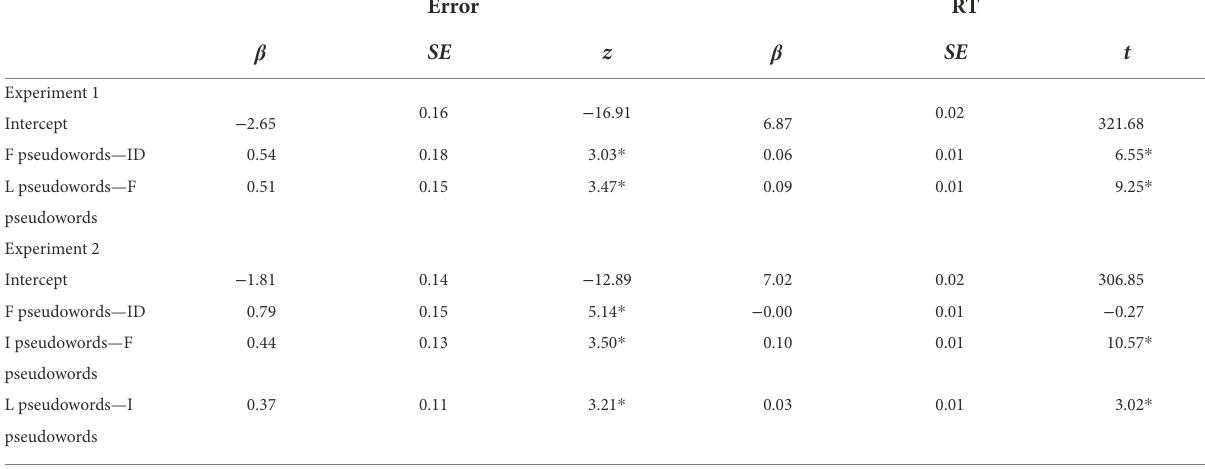
TABLE 2 Summary of statistical differences by type of pseudowords in Experiment 1 and Experiment 2.